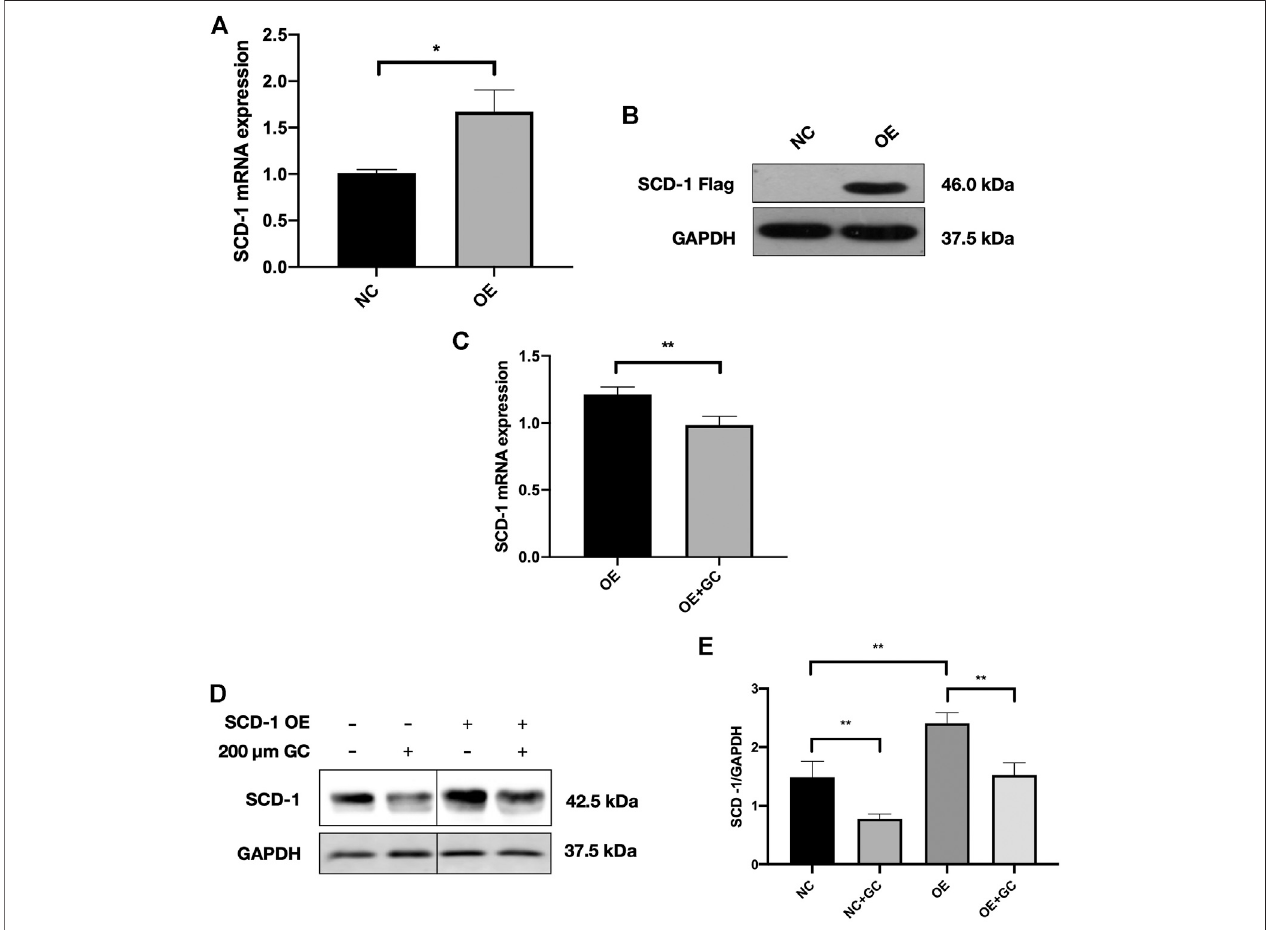
FIGURE 6 | The GC combination dramatically suppresses the SCD-1 expression in SCD-1 over-expressed cell models (A,B) SCD-1 mRNA and protein levels in lentivirus transfected SCD-1 over-expressed AML-12 cells (OE). The same vector without the SCD-1 insert was used as control (NC). (C) SCD-1 mRNA expression in cells was detected by qRT-PCR. (D) SCD-1 protein levels in cells were detected by immunoblotting, and the relative expression levels of proteins (E) were corrected by GAPDH. * p < 0.05, ** p <